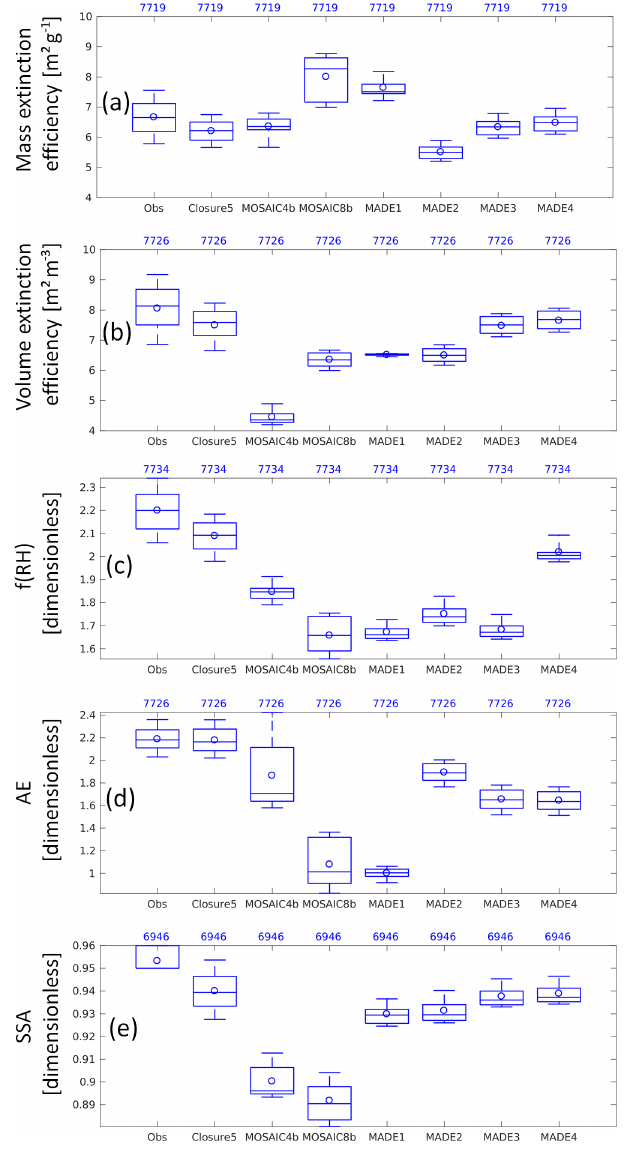
Figure 11. As Fig. 9 but comparing observations and the Closure 5 study to different modeling configurations (described in Table